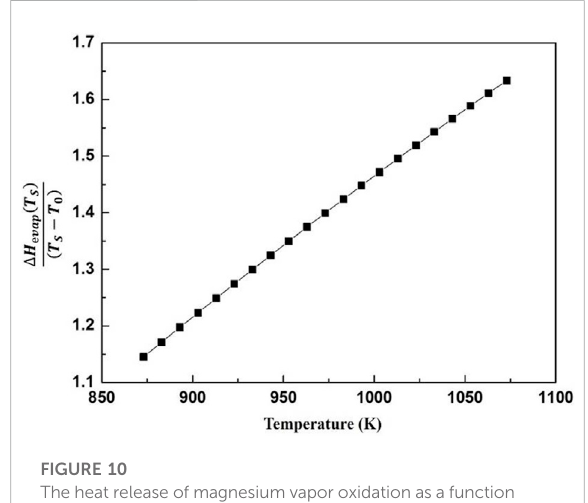
FIGURE 10 The heat release of magnesium vapor oxidation as a function of